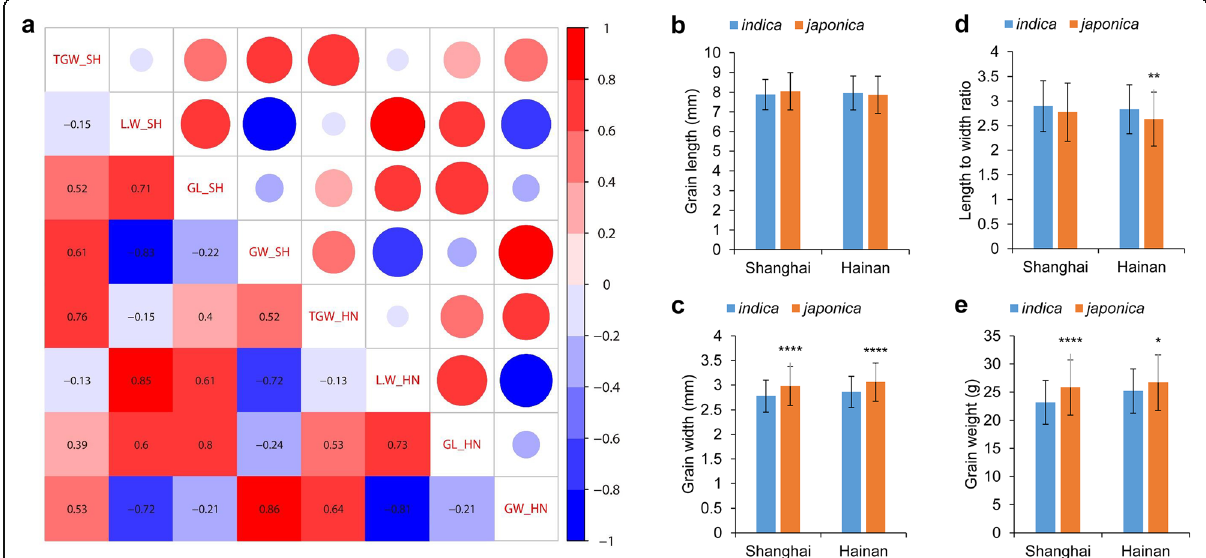
Fig. 3 Trait analysis of the RDP1 diversity panel. a Correlation analysis of four grain size traits at two locations, Shanghai and Hainan, China. The correlation coefficients are illustrated both by the circle size and color gradient ranging from 1 to − 1. Red and blue colors denote positive and negative correlations, respectively, and darker colors and larger circles correspond to greater correlations between traits. b - e Grain trait measurements between indica and japonica subspecies at two locations. *, ** and **** indicate significance at P < 0.05, P < 0.01 and P < 0.001 by Student ’ s t test,